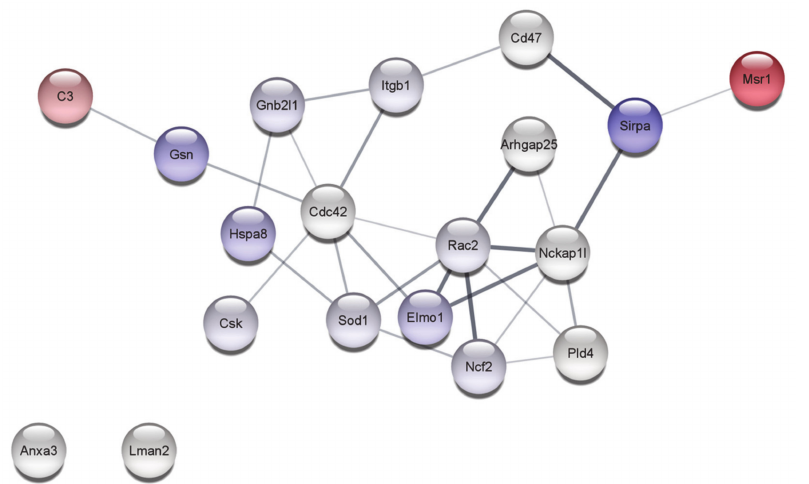
Figure 3. STRING network of PMJ2-R proteins involved in phagocytosis. Expression ratios were mapped to the nodes using blue-red gradient, where blue is related to the downregulated and red to the upregulated proteins. Network edges represent the confidence of interaction. The required interaction score was set to >0.4.